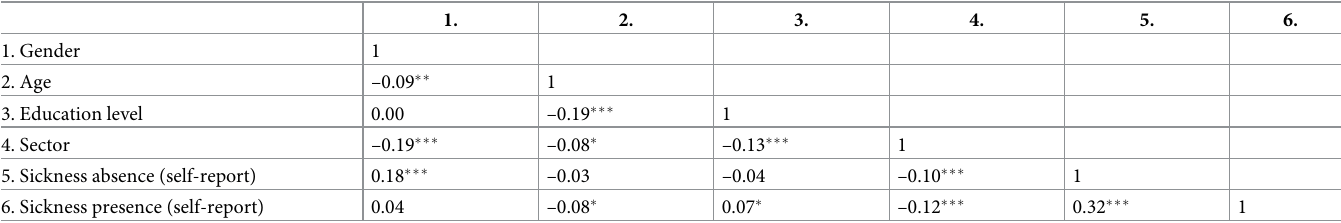
Table 5. Correlations between the main covariates in the self-reported sickness absence and sickness presence sample (n =